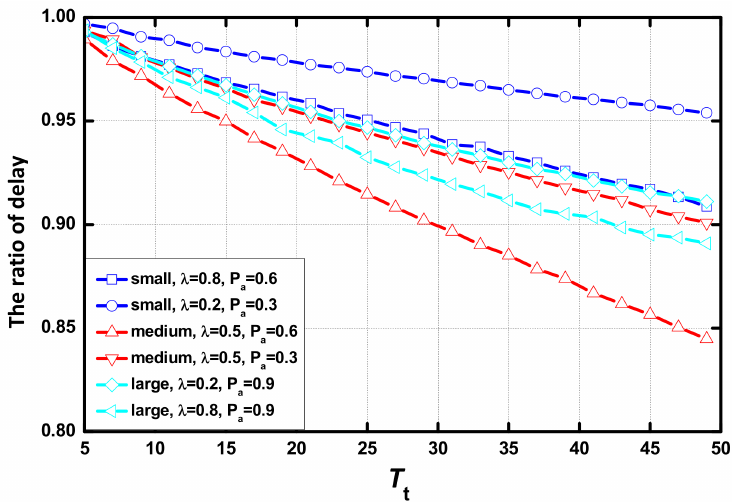
Figure 13. Ratio of average delay of the AAR scheme and the common scheme vs. T t .